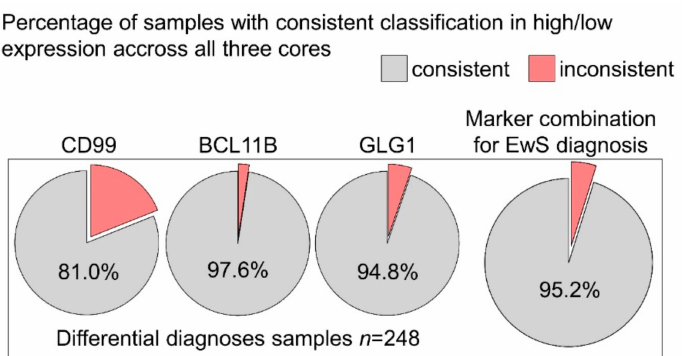
Figure 3. BCL11B and GLG1 show low intra-tumoral expression heterogeneity in di ff erential diagnosis for EwS. Pie charts indicating non-EwS samples with three cores evaluated in each staining ( n = 248) that were classified as high- or low-expressing the respective marker consistently (grey) or inconsistently (light red) across all three